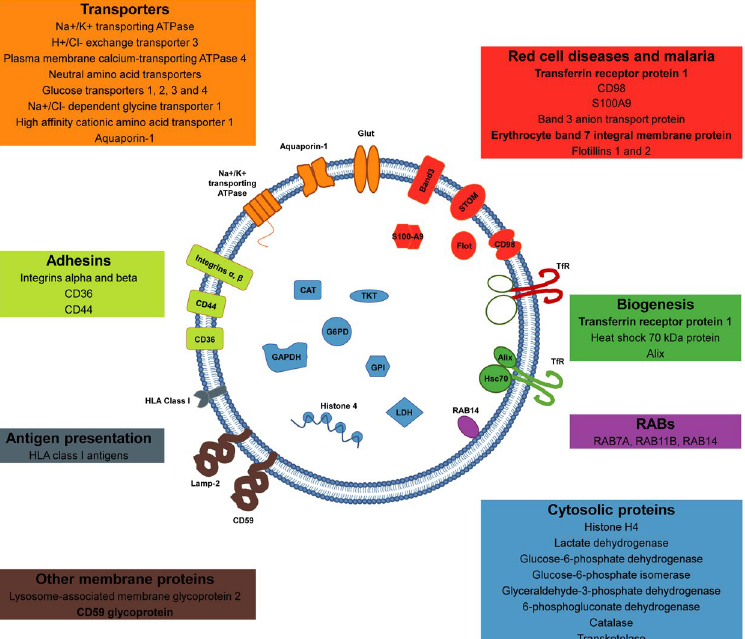
Figure 5. The human reticulocyte-derived exosome proteome. Schematic illustration of a human reticulocyte- derived exosome highlighting selected plasma membrane and cytosolic proteins. Transporters (in orange): Na + /K + transporting ATPase (ATP1A1, ATP1B3), H + /Cl − exchange transporter 3 (CLCN3), Plasma membrane calcium-transporting ATPase 4 (ATP2B4), Neutral amino acid transporters (SLC1A5, SLC43A1, SLC7A5), Glucose transporters 1, 2, 3 and 4 (SLC2A1, SLC2A2, SLC2A3, SLC2A4), Na + /Cl − dependent glycine transporter 1 (SLC6A9), High affinity cationic amino acid transporter 1 (SLC7A1) and Aquaporin-1 (AQP1). Adhesins (in lime): Integrin alpha and beta (ITGA2B, ITGA4, ITGAM, ITGB1, ITGB2, ITGB3), CD36 and CD44. Other membrane proteins (in brown): Lysosome-associated membrane glycoprotein 2 (LAMP2) and CD59 glycoprotein (CD59). Antigen presentation (in grey): HLA class I antigens (HLA-A, HLA-C). RABs (in pink): RAB7A, RAB11B and RAB14. Biogenesis (in green): Transferrin receptor protein 1 (TFRC), Heat shock 70 kDa protein (HSPA8, HSPA1A) and Alix (PDCD6IP). Cytosolic proteins (in blue): Histone H4 (HIST1H4A), Lactate dehydrogenase (LDHA, LDHB), Glucose-6-phosphate dehydrogenase (G6PD), Glucose-6-phosphate isomerase (GPI), Glyceraldehyde-3-phosphate dehydrogenase (GAPDH), 6-phosphogluconate dehydrogenase (PGD), Catalase (CAT) and Transketolase (TKT). Red cell diseases and malaria (in red): Transferrin receptor protein 1 (TFRC), CD98 (SLC3A2, SLC7A5), S100A9, Band 3 anion transport protein (SLC4A1), Erythrocyte band 7 integral membrane protein (STOM) and Flotillins 1 and 2 (FLOT1, FLOT2). Proteins in bold have been previously described in human reticulocyte-derived exosomes (TfR, STOM, CD59) 7,13,14